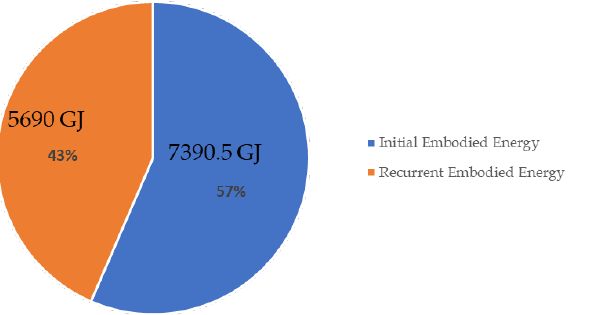
Figure 3. Proportion of initial and recurrent embodied energy for the case study villa.